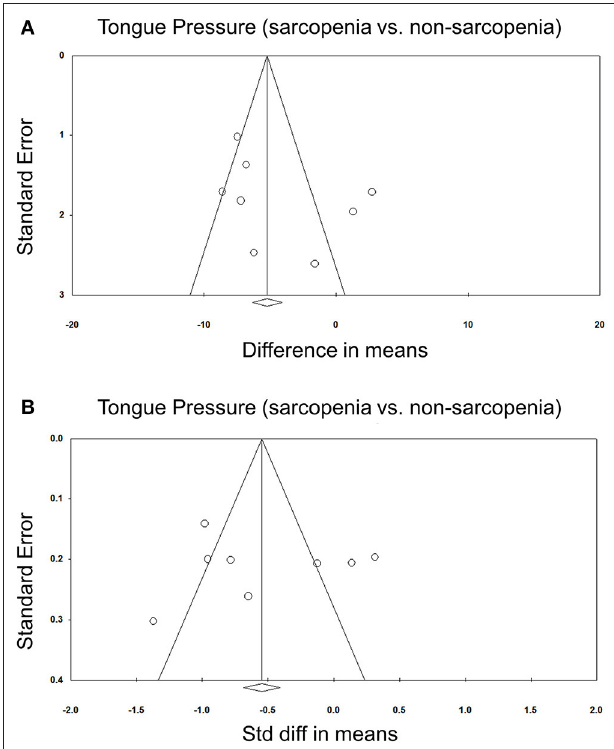
FIGURE 4 | Funnel plot of the weighted mean difference (A) and standardized mean differences (B) of the tongue pressure between the sarcopenic and non-sarcopenic groups among the included studies. Std diff, standardized difference.